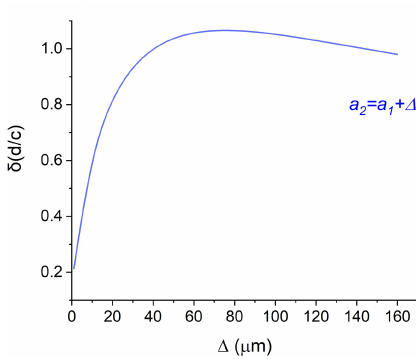
Figure 5: Dependence of the growth rate on beam thick- ness. ε r = 2 . 7, R 1 = 240 µ m, R 2 = 400 µ m, l = 80 µ m, d = 160 µ m, a 1 = 400 µ